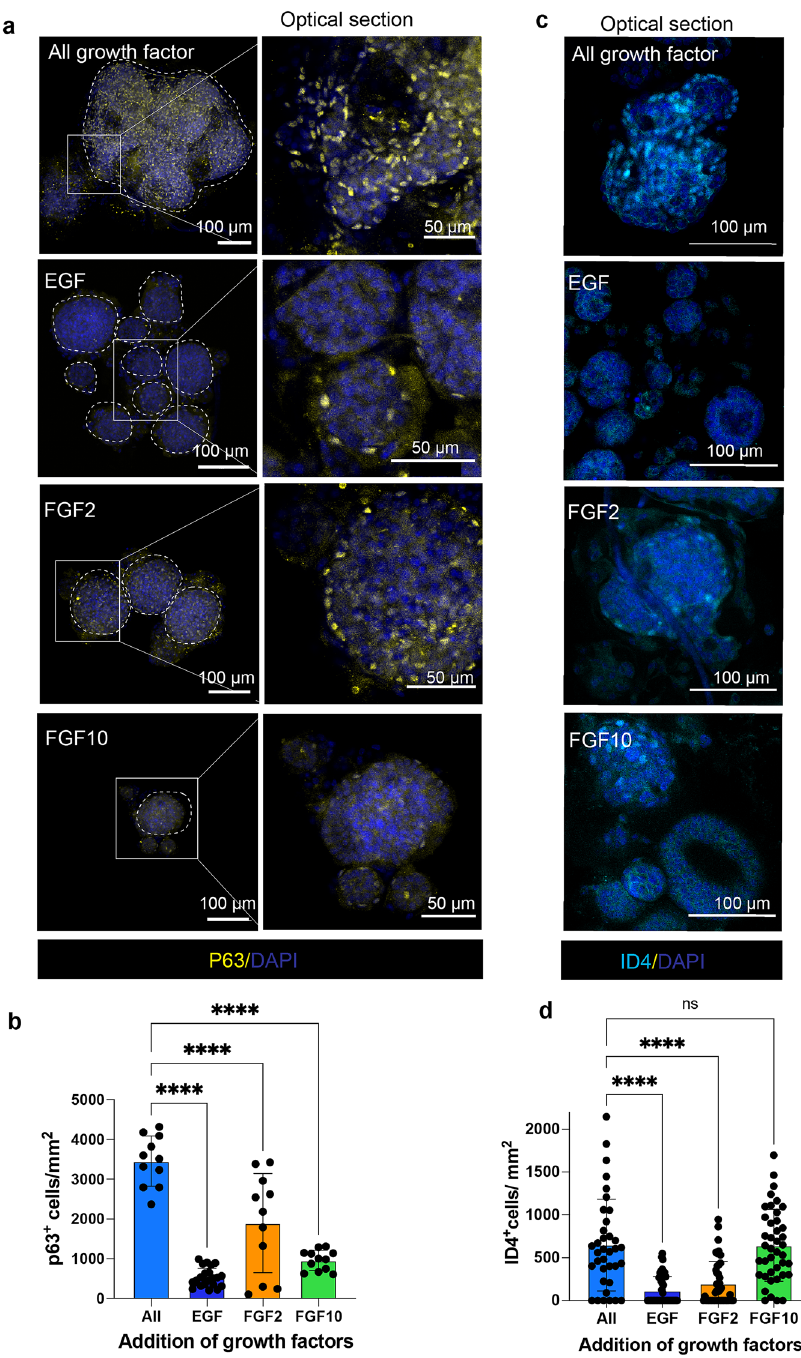
Figure 2. Mammary stem cell-specific transcription factors are expressed in organoids cultured in a cocktail of growth factors. ( a ) Representative images showing the expression of transcription factor p63, mostly expressed in basal epithelial cells in each condition (Scale bar = 100 µm). ( b ) Quantification showing the significant increase in p63 + cells in individual organoids cultured in a cocktail of growth factors as compared to EGF, FGF2, or FGF10 alone. Each dot represents total cells/mm 2 in each organoid. Results are expressed as mean ± SD and one-way ANOVA for multiple comparison test was used to measure statistical significance. (n = 11–23 organoids per condition). ( c ) Representative images showing the expression of transcriptional factor ID4 in mammary organoids cultured in individual growth factors (Scale bar = 100 µm). ( d ) Quantification showing the significant increase in ID4 + cells in individual organoids cultured in a cocktail of growth factors. Results are expressed as mean ± SD and one-way ANOVA for multiple comparison test was used to measure statistical significance. (n = 36–44 organoids per condition). Each dot represents total cells/mm 2 in each